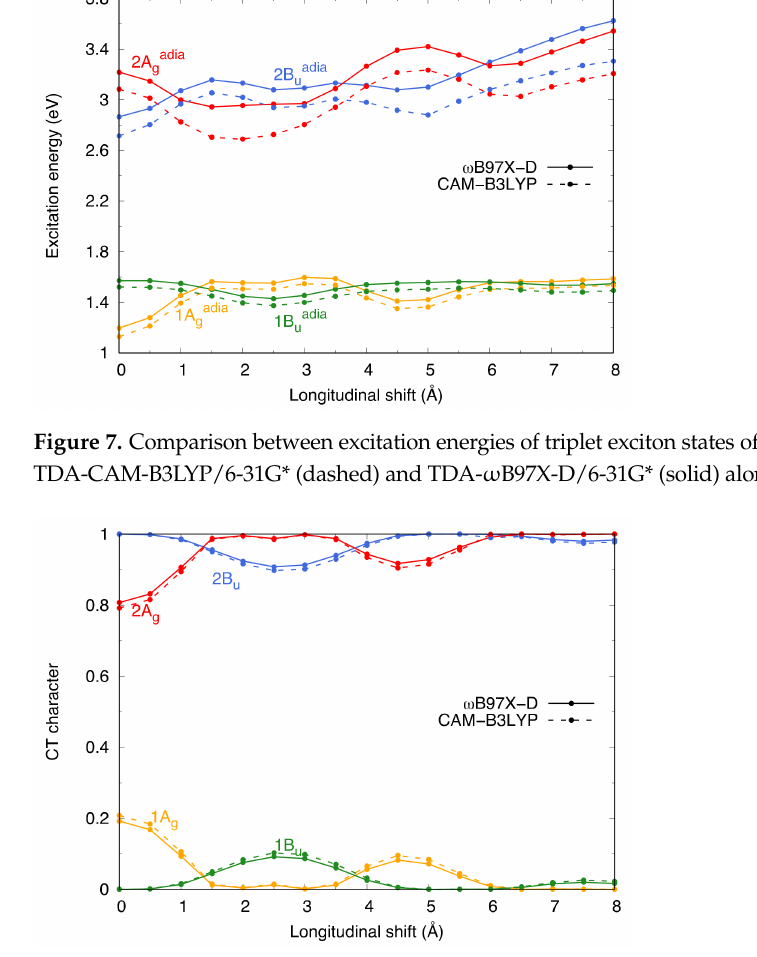
Figure 8. Comparison between triplet exciton CT character computed with TDA-CAM-B3LYP/6-31G* (dashed) and TDA- ω B97X-D/6-31G* (solid) calculations.